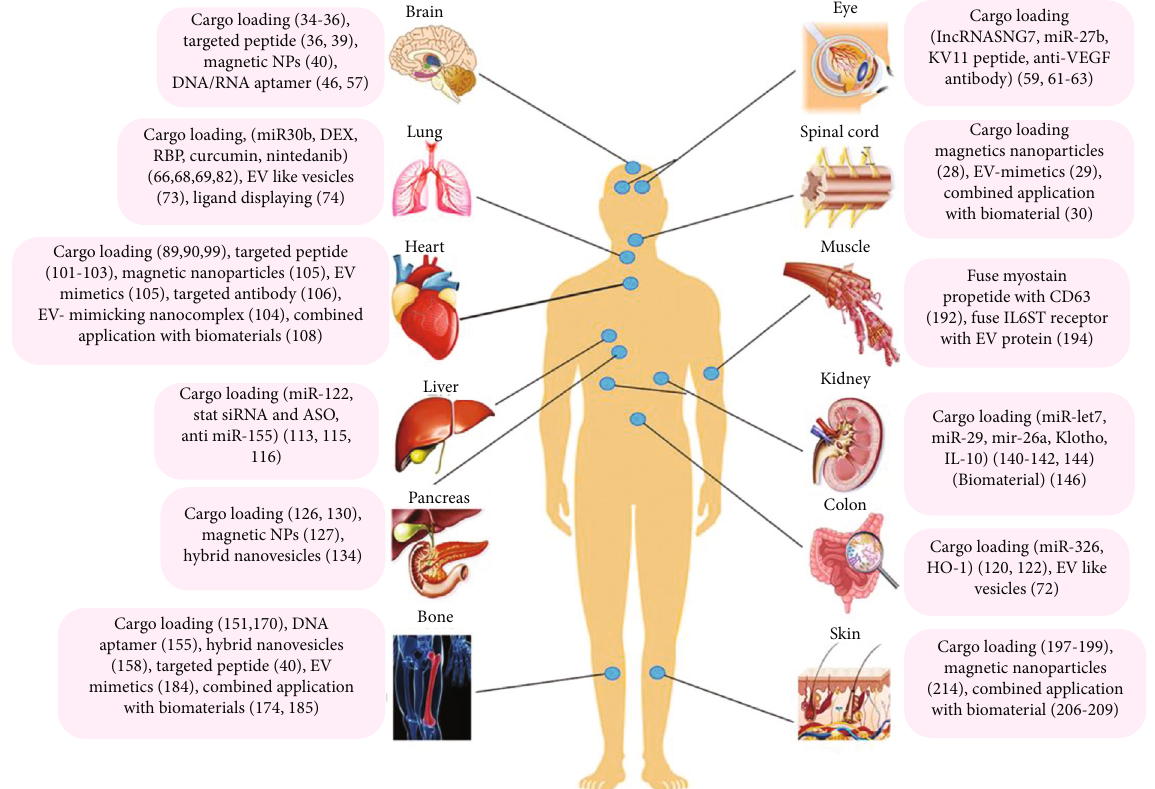
Figure 1: Engineered EV enhances major tissue and organ repairs. The modi fi cation approaches of EVs in the therapy of tissue and organ injury mainly involve four aspects: cargo loading, targeting modi fi cation, EV mimetics and EV-mimicking nanocomplex, and the combined application of EV with